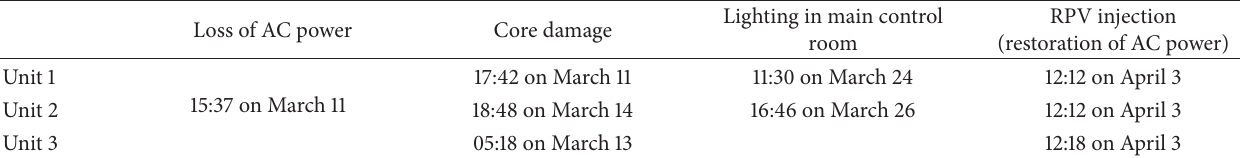
Table 1: Restoration of AC